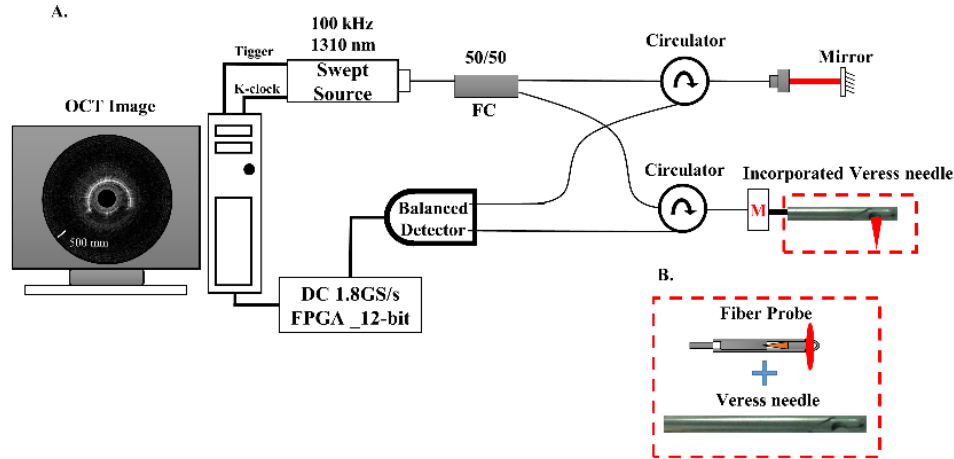
Figure 1. ( A ) Schematic layout of incorporated Veress needle-based swept-source optical coherence tomography (SSOCT) system. An OCT image of the needle’s inner layer obtained using the OCT needle probe system. FC: fiber coupler, DC: digitizer card, FPGA: field-programmable gate array. ( B ) Schematic of the Veress needle combined with the fiber probe.